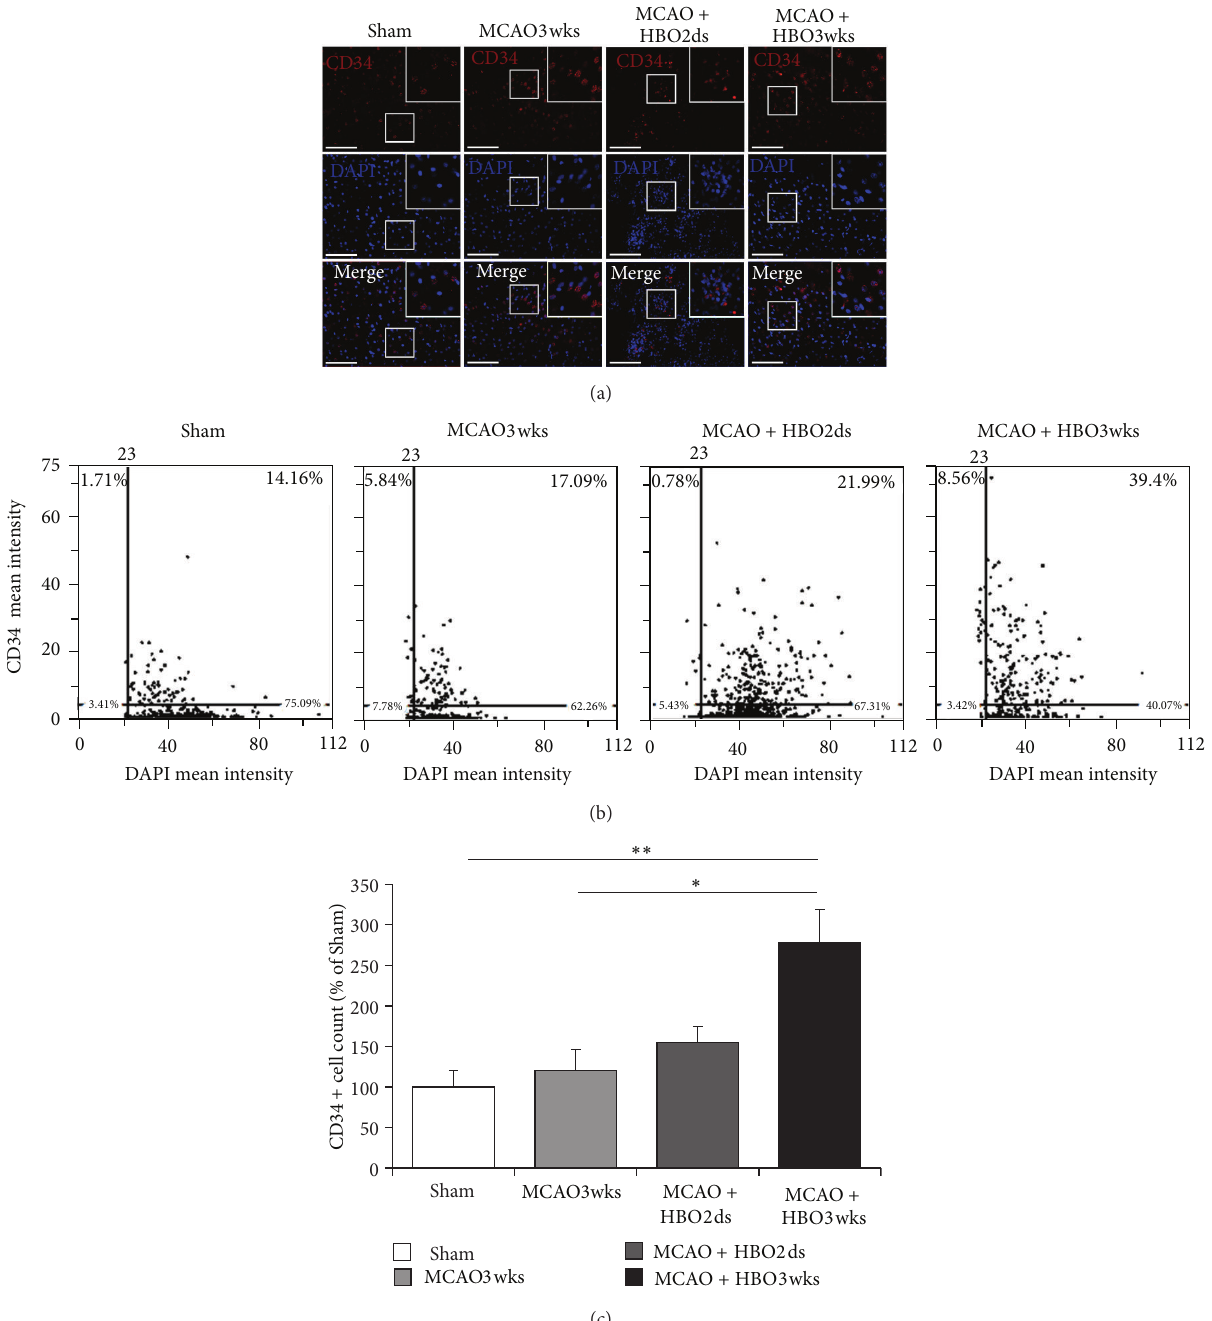
Figure 3: Long course HBO improved BMSCs migration to brain. (a) Demonstration of CD34-DAPI double staining showed presentation of BMSCs after brain ischemia. (b) Representative image of tissue cytometry using TissueQuest software. CD-34 positive cells and DAPI positivecellswerecountedandthesignalintensitywasquantified.(c)TheamountofdoublepositivecellswithCD34andDAPIintheischemic boundarywasrecordedasthepercentageofCD34positivecellsinallcells.Thedifferencewassignificant,ascomparedwithMCAO3wksgroup and HBO3wks group ( ∗ 𝑃 < 0.05 ). The difference was more significant, as compared with Sham group and HBO3wks group ( ∗∗ 𝑃 < 0.01